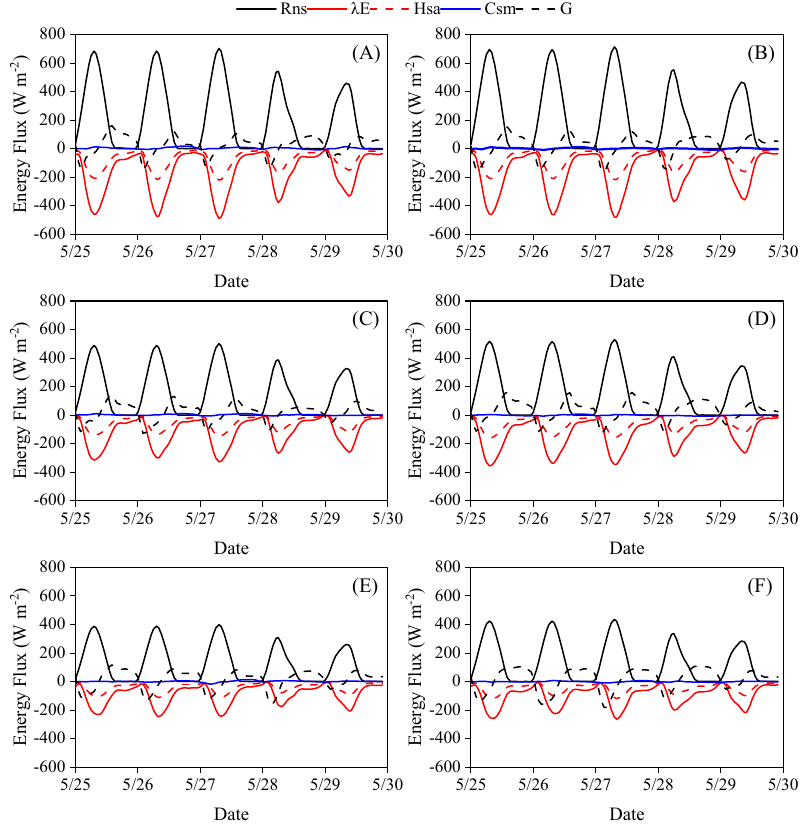
Figure 11. Simulated energy balance for the six treatments: ( A ) T1; ( B ) T2; ( C ) B1; ( D ) B2; ( E ) G1; ( F ) G2. Included are the net radiation at the soil surface ( R ns ); the latent heat flux between the soil surface and atmosphere ( λ E ); the air sensible heat flux between the soil surface and the atmosphere ( H sa ); the heat conduction between the plastic film and the soil surface ( C sm ); and the heat flux downward through the soil surface ( 𝐺 ).